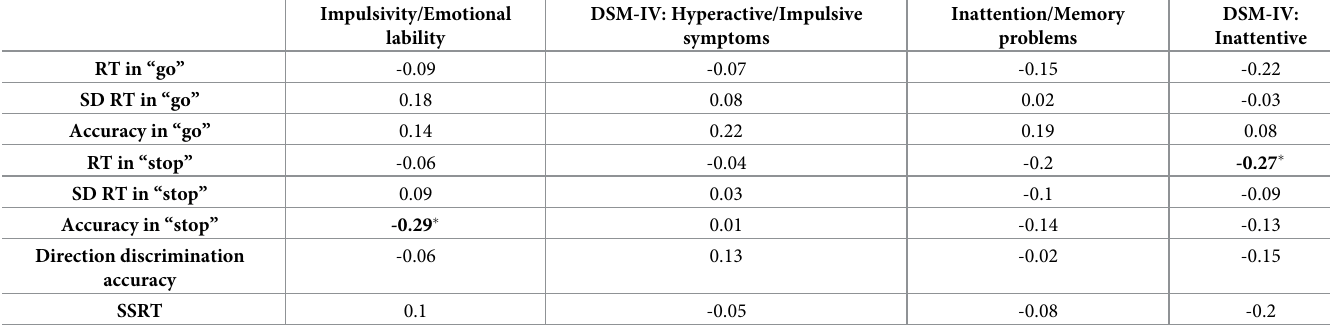
Table 2. Values of Spearman’s ρ for correlations between keypress measures and impulsivity/inattention measures. Impulsivity/Emotional lability